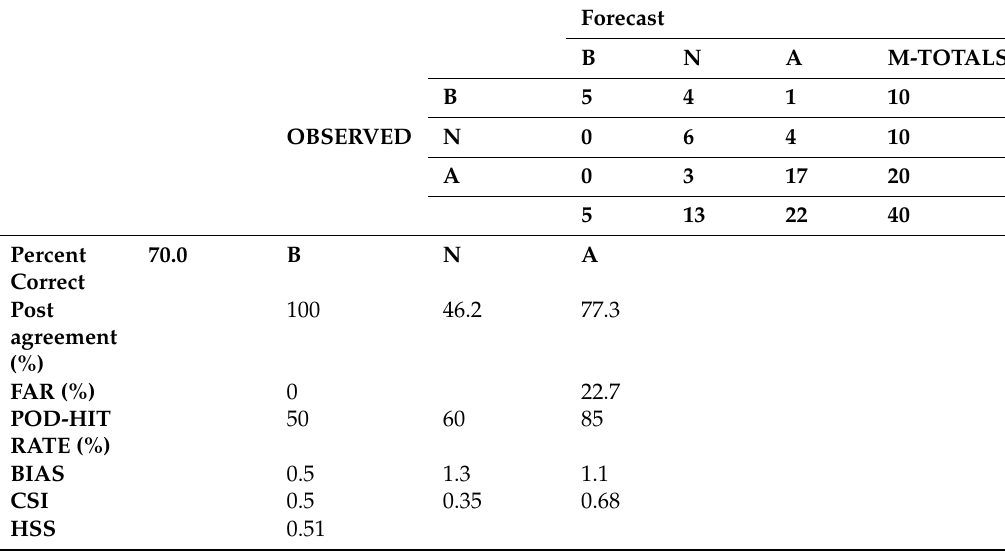
Table 5. Contingency